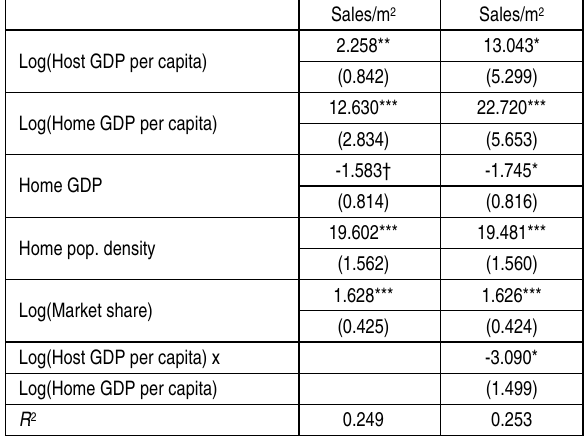
Table 3. Fixed effect model of retailer